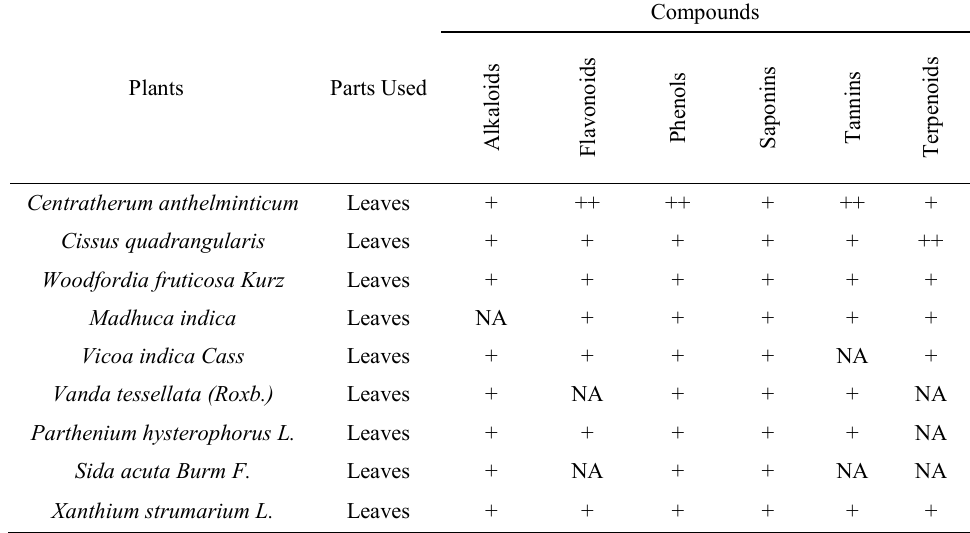
Table 1. Phytochemical constituents of methanolic leaf extracts.